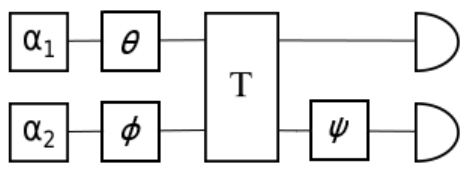
Figure 1. Optimal joint estimation scheme for two modes using a beam splitter of transmittance T and two homodyne detectors. The phases are all set to zero in Equation